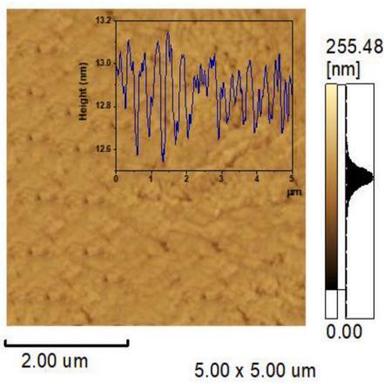
AFM image, and roughness distribution of PVA structure.